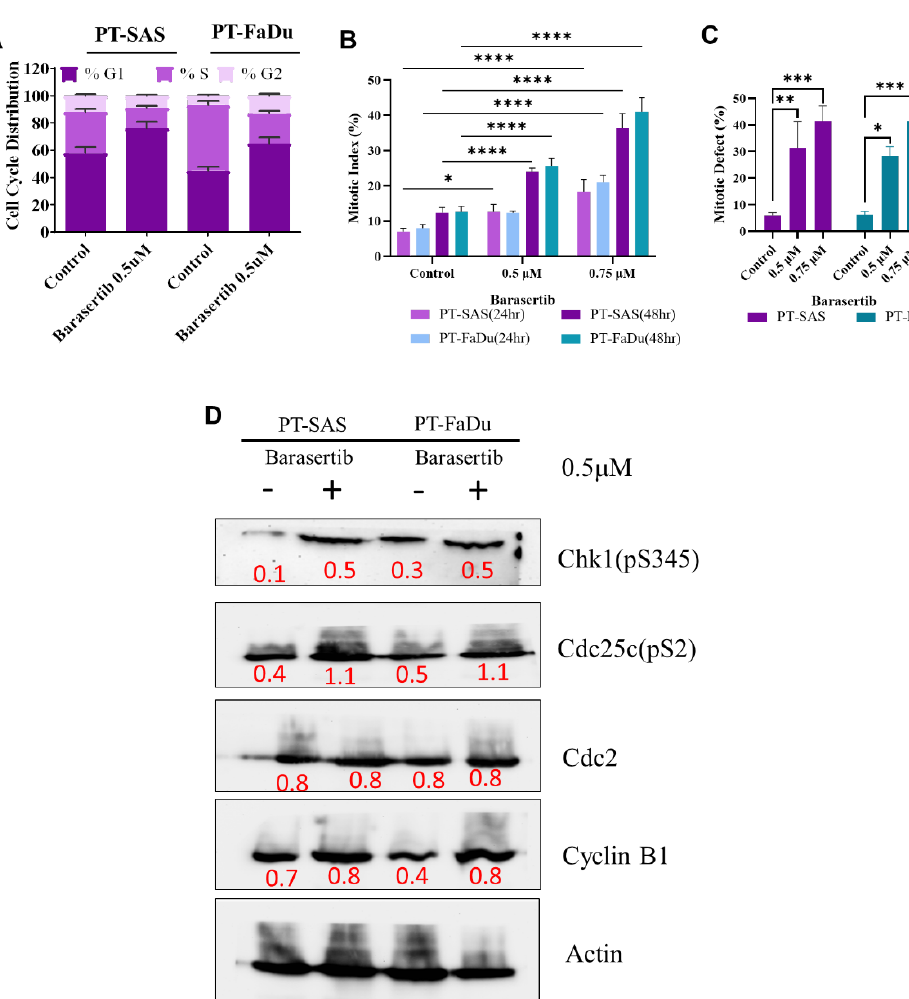
Figure 6. AURKB inhibition promoted mitotic catastrophe in HNSCC persister cells. ( A ) Treatment with AURKB inhibitor, barasertib, induced cell cycle arrest in both PT-SAS and PT-FaDU cells by markedly increasing the G1 cell subpopulation while reducing the G2 and S cell subpopulations. ( B ) Bar graph described dose-dependent and time-dependent significant perturbation of mitotic activity of PT-SAS and PT-FaDU cells upon barasertib treatment. ( C ) The percentage of mitotic defects following barasertib treatment increased in a dose-dependent manner. ( D ) AURKB inhibition modulated several cell cycle regulators and activated mitotic catastrophes markers, such as Chk1, Cdc25 and Cyclin B1, suggesting the inhibition of cell cycle progression despite the enhancement of mitosis. Significance level: * p < 0.05; ** p < 0.01; *** p < 0.001; **** p < 0.0001.